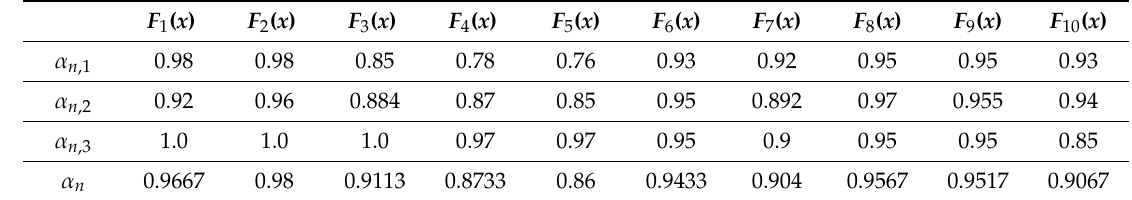
Table 1. Confidence levels for scalar